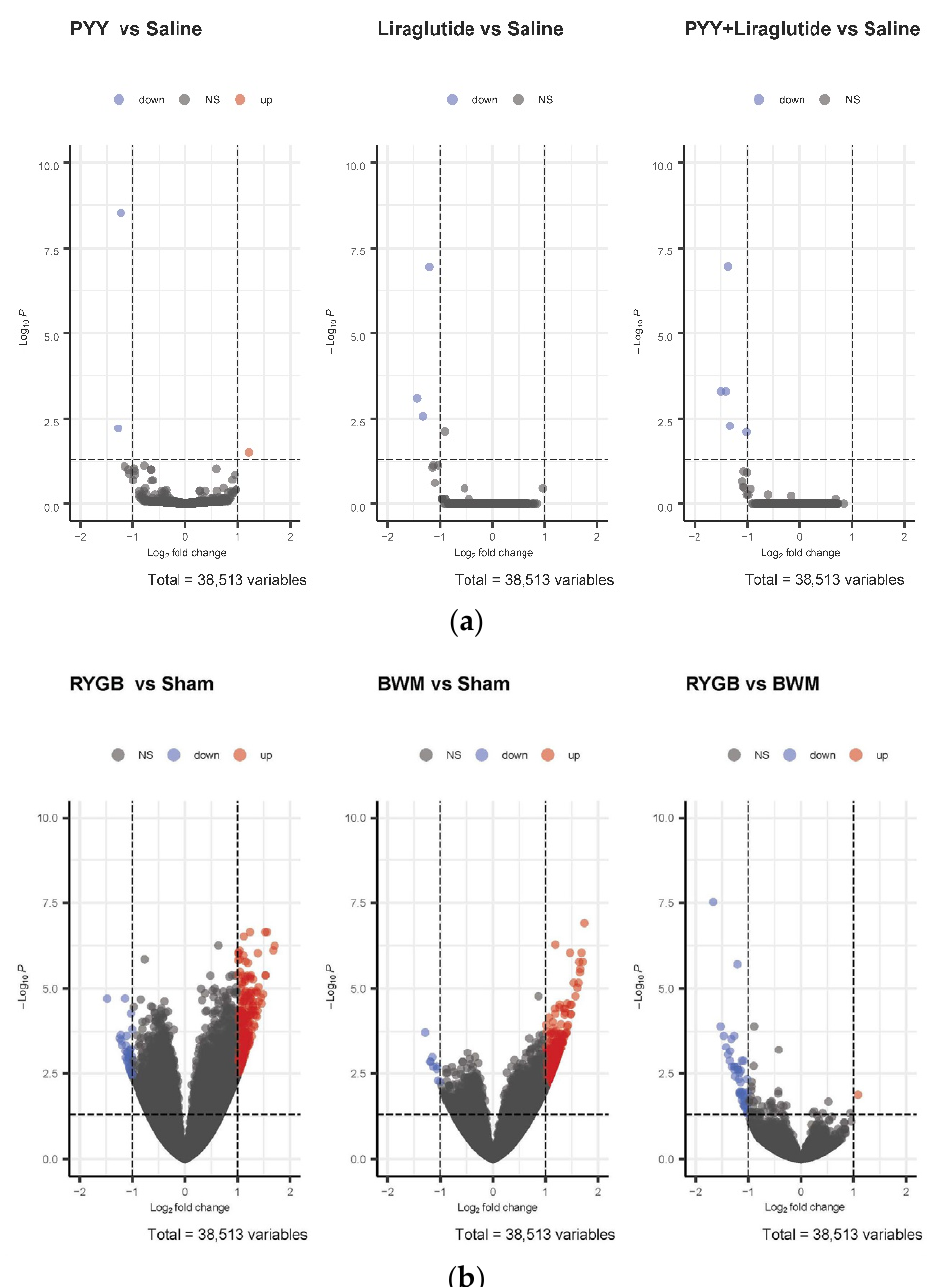
Figure 2. ( a ) Volcano plots of differentially expressed genes in the hypothalami of PYY- vs. saline- treated animals, liraglutide- vs. saline-treated animals and PYY3-36 + liraglutide- vs. saline-treated animals. ( b ) Volcano plots of differentially expressed genes in hypothalami of RYGB- vs. sham-treated animals, BWM vs. sham-treated animals and RYGB-treated vs. BWM treated animals.